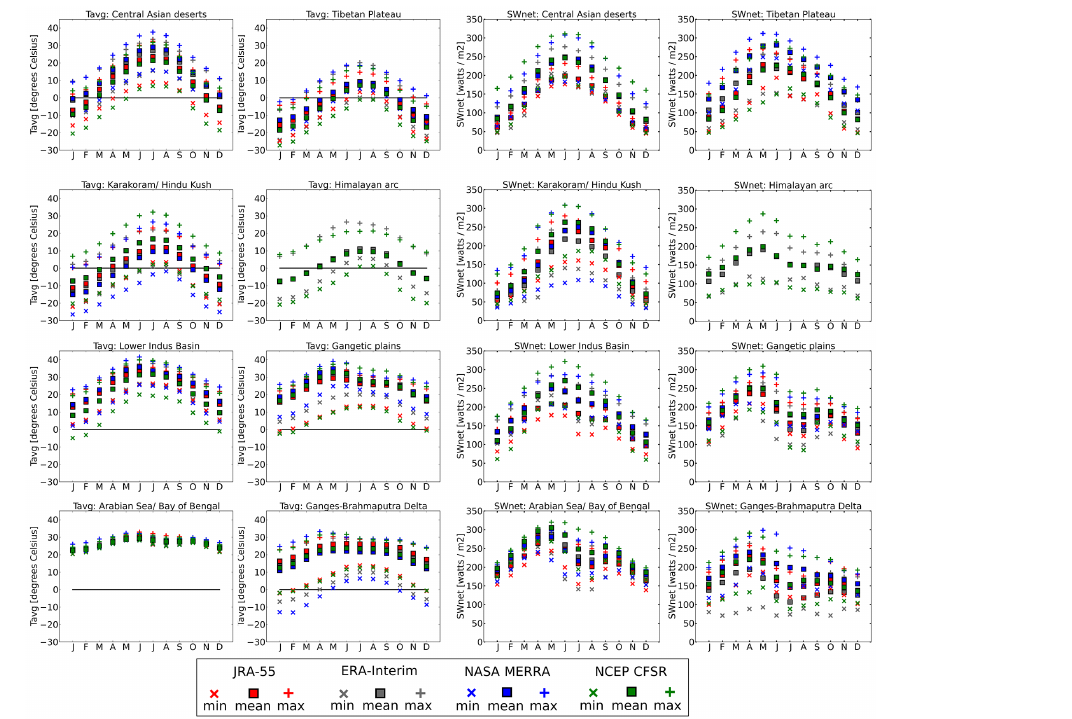
Figure 7. Ensemble spatial statistics for annual cycles of T avg and SW net by climate zone (eight clusters). SW net is net downward shortwave radiation at the surface. T avg is daily mean near surface air